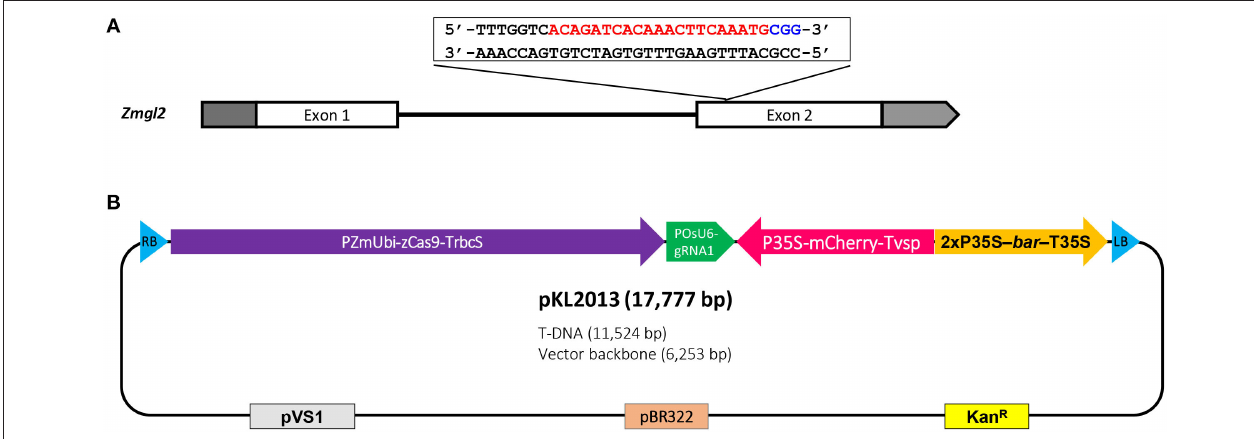
FIGURE 5 | Schematic illustration of maize glossy2 ( gl2 ) gene target sequence and CRISPR-Cas9 construct for Agrobacterium -mediated transformation. (A) Maize Gl2 has two exons and the target sequence is located near the 5 ′ end of the second exon. The protospacer (red) and PAM (blue) are indicated; (B) The CRISPR-Cas9 construct, pKL2013, has an 11.5kb T-DNA which includes maize-codon-optimized SpCas9 driven by maize ubiquitin promoter, sgRNA1 cassette driven by rice U6 promoter, mCherry cassette driven by CaMV 35S promoter, and bar selectable marker driven by CAMV 35S promoter. RB, T-DNA right border; PZmUbi-zCas9-TrbcS, maize ubiquitin promoter driving maize-codon-optimized SpCas9 (zCas9) with ribulose-1,5-bisphosphate carboxylase/oxygenase small subunit 2b terminator; POsU6-gRNA1, rice U6 promoter driving sgRNA1 with rice-U6-2 terminator; P35S-mCherry-Tvsp, CaMV 35S promoter driving mCherry with soybean vegetative storage protein terminator; 2xP35S-bar-T35S, CaMV 35S promoter driving phosphinothricin N-acetyltransferase ( bar ) with CaMV 35S terminator; LB, T-DNA left border; pVS1, origin of replication from the plasmid pVS1; pBR322, origin of replication from the plasmid pBR322; Kan R , aminoglycoside phosphotransferase gene providing resistance to